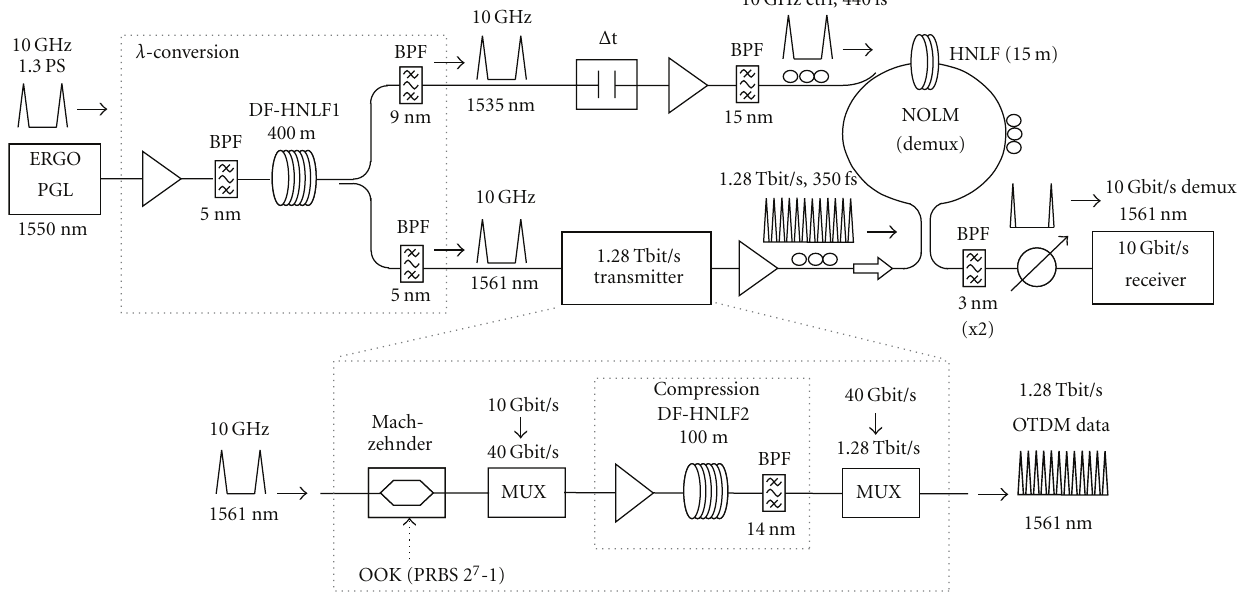
Figure 2: Experimental set-up for a back-to-back demonstration of 1.28Tbit/s serial data generation and demultiplexing.